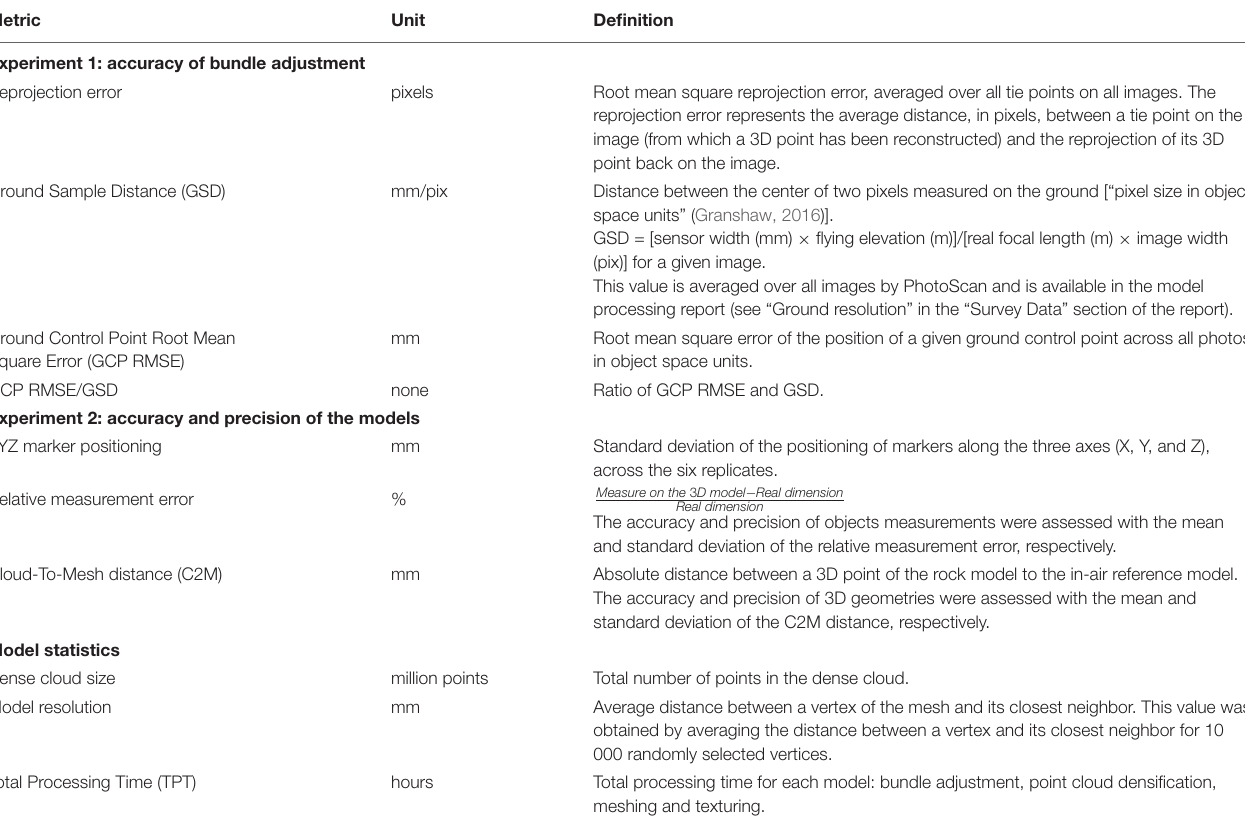
TABLE 2 | Definition of the metrics used in this